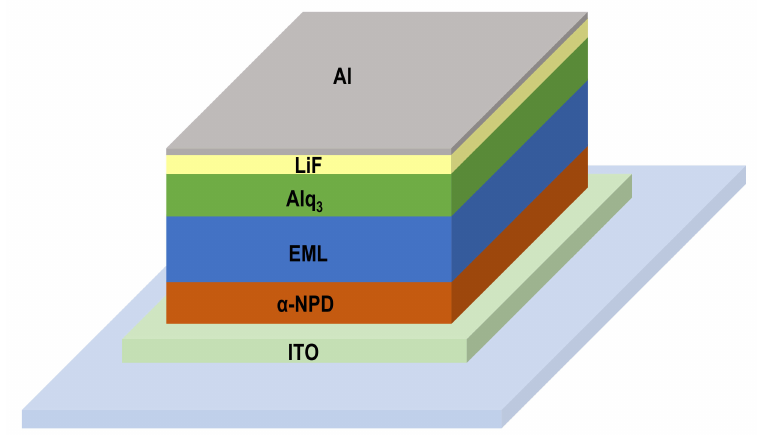
Figure 1. Schematic device structure of the OLED devices under